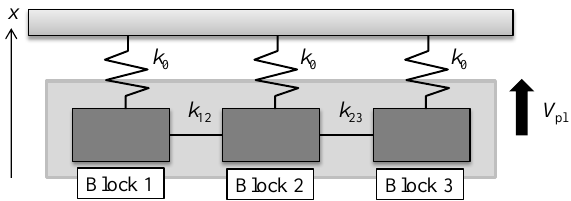
Figure 1. Schematic diagram of a three-degree-of-freedom spring- block model. Blocks 1, 2, and 3 are connected to a fixed wall with springs of stiffness k 0 , and connected to each other with springs of stiffness k 12 and k 23 between Blocks 1 and 2 and Blocks 2 and 3, respectively. The three blocks are driven by a belt conveyor moving at a rate of V pl